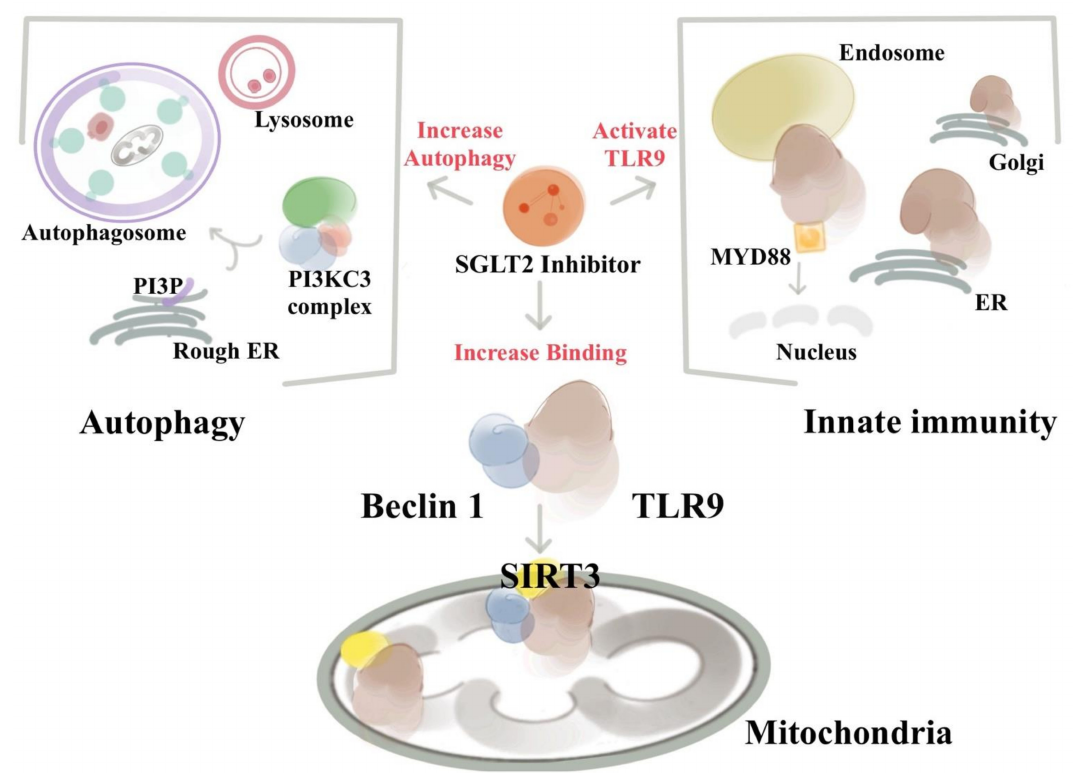
Figure 1. SGLT2 inhibitors activate the Beclin 1–TLR9–SIRT3 complex and connect the autophagy and the innate immune system. The existence of an integrated Beclin 1, TLR9, and SIRT3 network involving autophagy, oxidative stress, and mitochondria is essential for the ability of SGLT2 to protect the heart. SGLT2 inhibitor treatment enhances the activation of TLR9 to bind with Beclin 1 and increases the abundance of mitochondrial SIRT3. The bindings of Beclin 1 and TLR9 via SGLT2 inhibitors trigger the communications between the autophagic, innate immune system, and inflammatory machinery. The increased abundances of SIRT3 after SGLT2 inhibitor treatments then direct the Beclin 1–TLR9 complex to traffic toward the mitochondria, where the activated TLR9 enhances the mitochondrial respiration rate and exerts its protection against ROS and apoptosis. Of particular interest from a therapeutic standpoint is the finding that due to the deficiency of SIRT3 in mice and humans, both lose the SGLT2 inhibitors’ protective